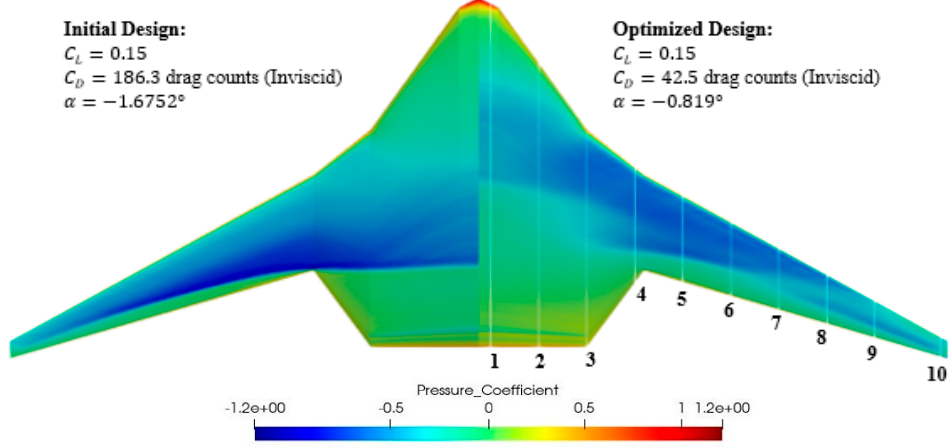
Figure 11. Pressure coefficient contours of the upper aircraft surfaces for initial and optimized configurations.